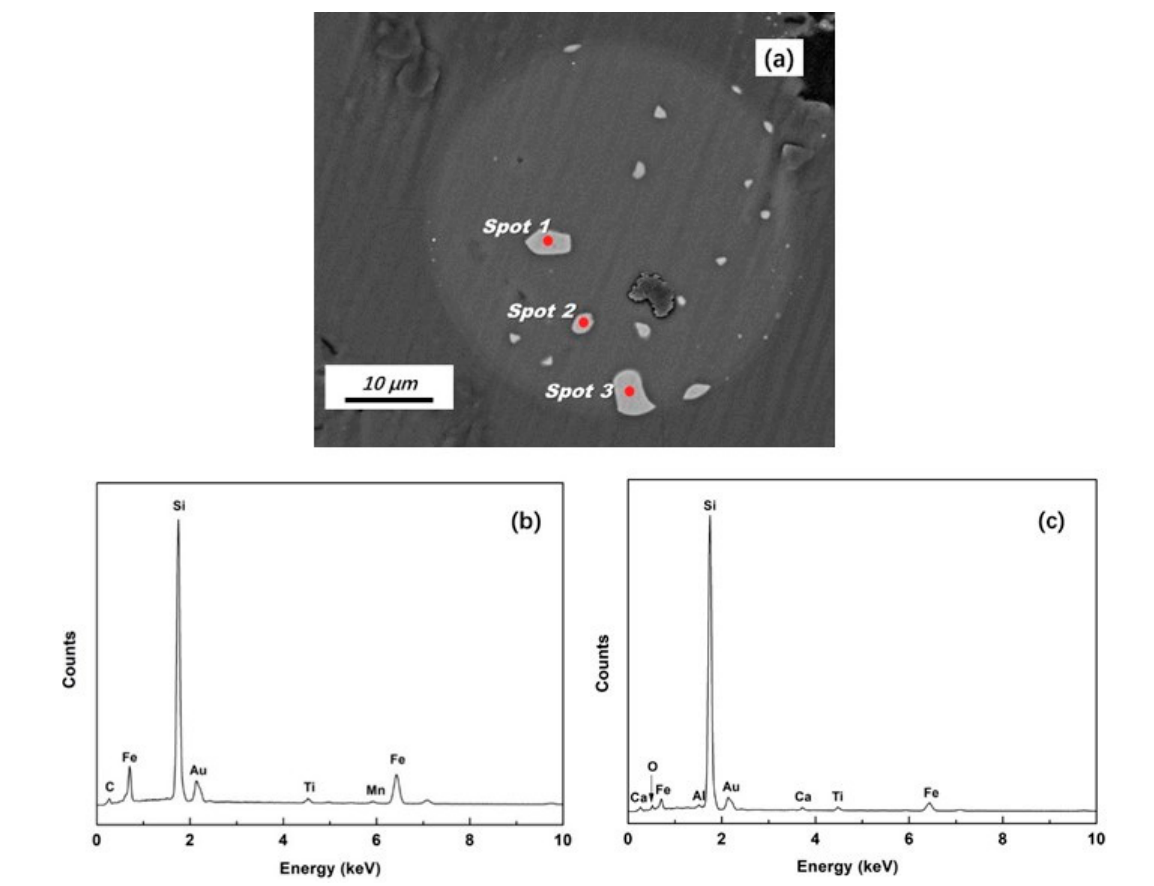
Figure 6. A typical backscattered electron image of silicon droplet in slag (BI = 1.4) near silicon–slag interface ( a ); EDS analyses at spot 1 ( b ) and spot 3 ( c ). Table 5. Composition of impurities in silicon droplet, wt%.